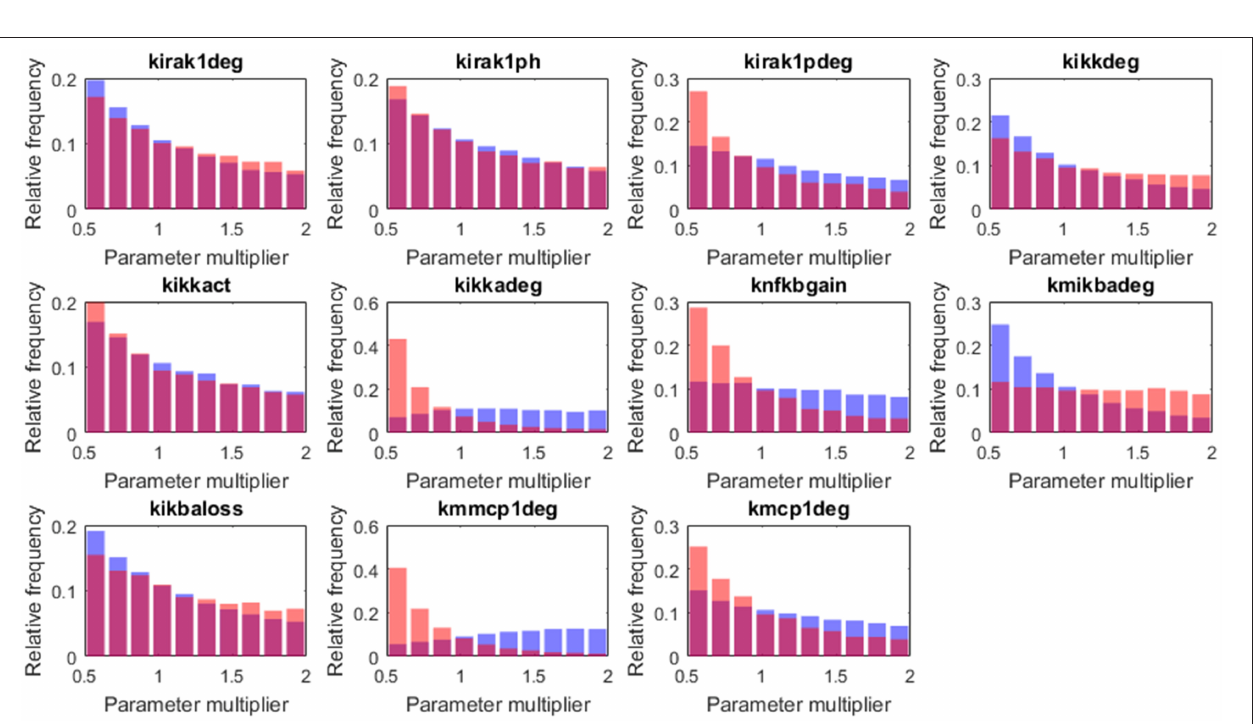
FIGURE 9 | Histograms of the tissue level parameter values: high load group in red and low load in blue. We plotted the factors that multiply the value of the nominal solution. The distribution of solutions for a different sample number is shown in Supplementary Material.